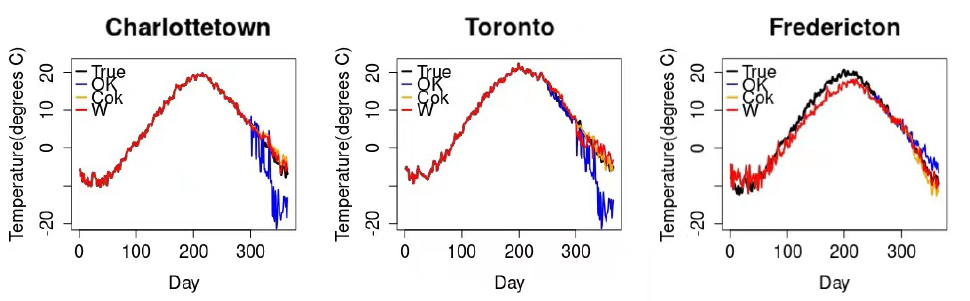
Figure 8. Predictions of Canadian